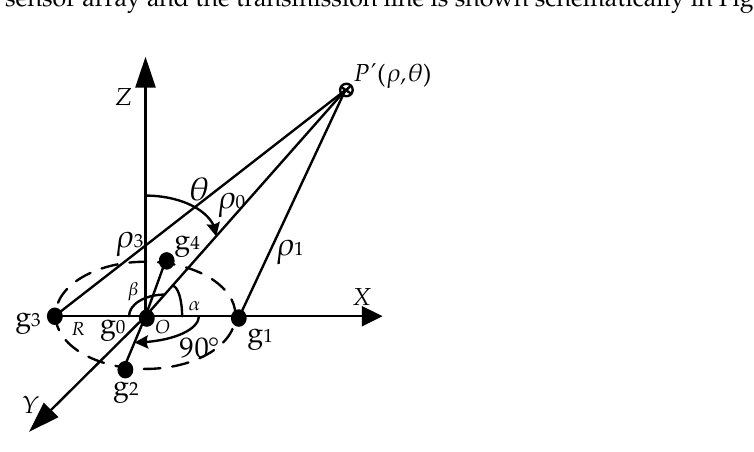
Figure 4. Schematic diagram of the sensor array plane. The distance and elevation angle of the drone to the transmission line are based on the values of the three sensors, g3, g0, and g1. Where the three sensors, g3, g0, and g1, are located in a straight line perpendicular to the transmission line, a spatial location of the sensor array and the transmission line is shown schematically in Figure 5.